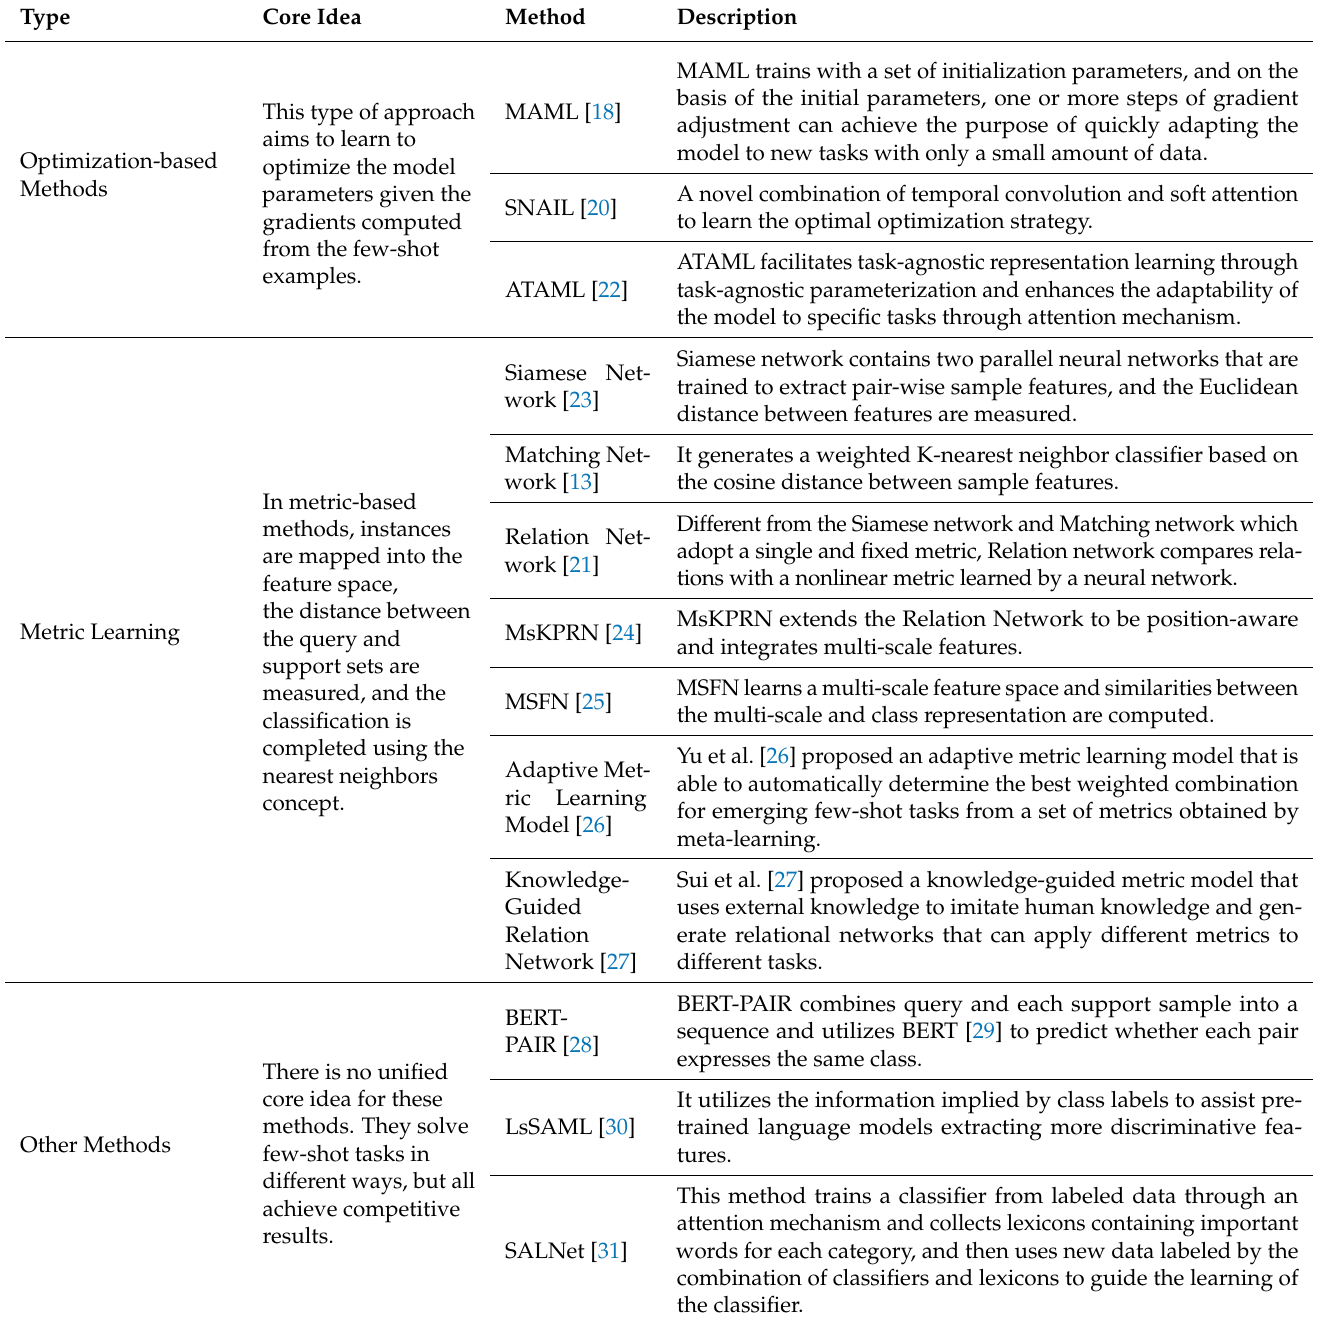
Table 1. Representative few-shot learning methods and their